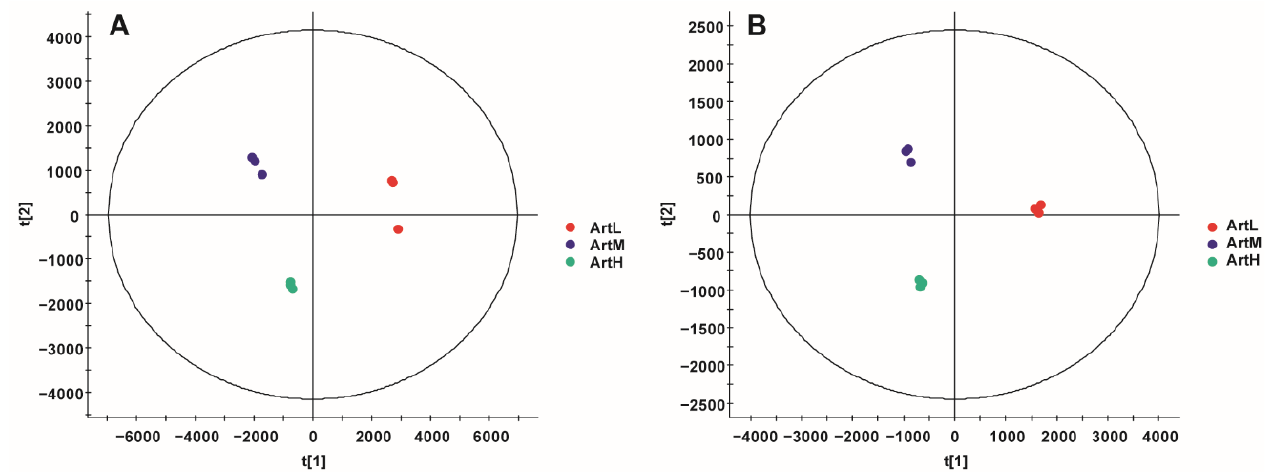
Figure 2. PCA score plot of the ether extracts from three Artemisia annua L. ( A ) positive-ion mode. ( B ) negative-ion mode ( n = ( B ) negative-ion mode ( n = 3).